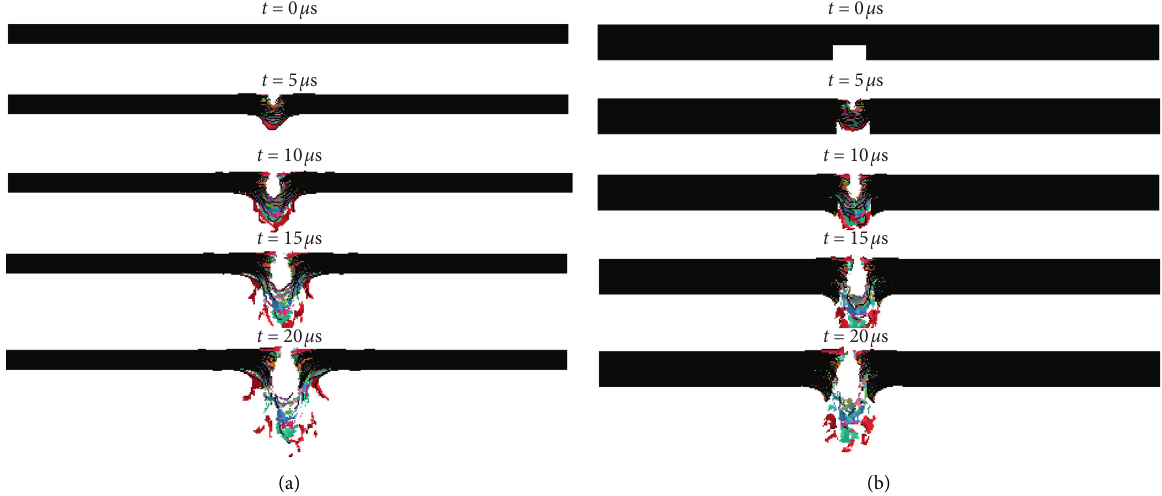
Figure 6: Cutting process of the laminate (a) without and (b) with weakening groove.